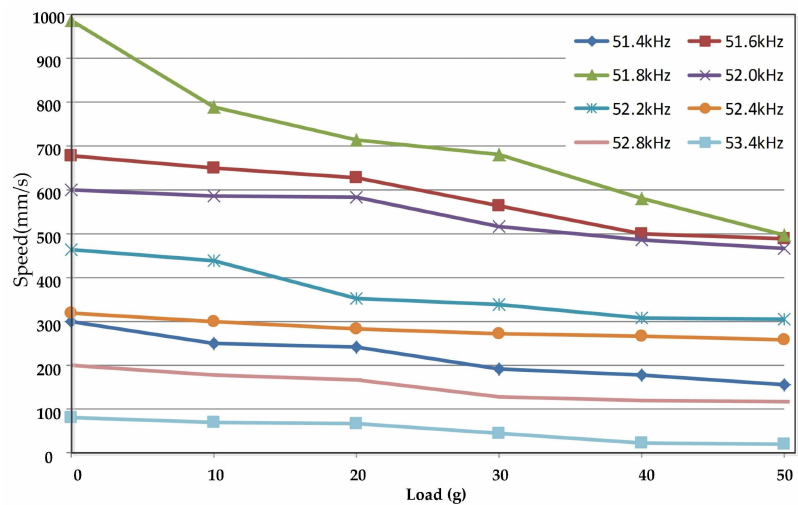
Figure 18. Load speed curve in di ff erent